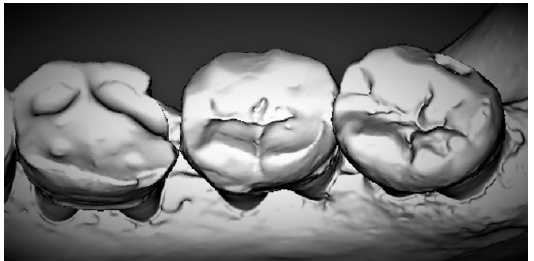
Figure 9. Group of molars; the second molar is in the middle position